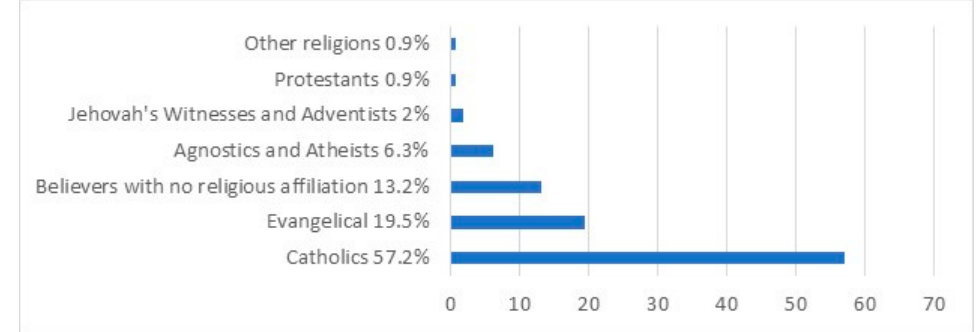
Figure 2. Religious affiliation of Colombians. Source: Author’s own compilation based on studies by Beltrán and Silva (2020).